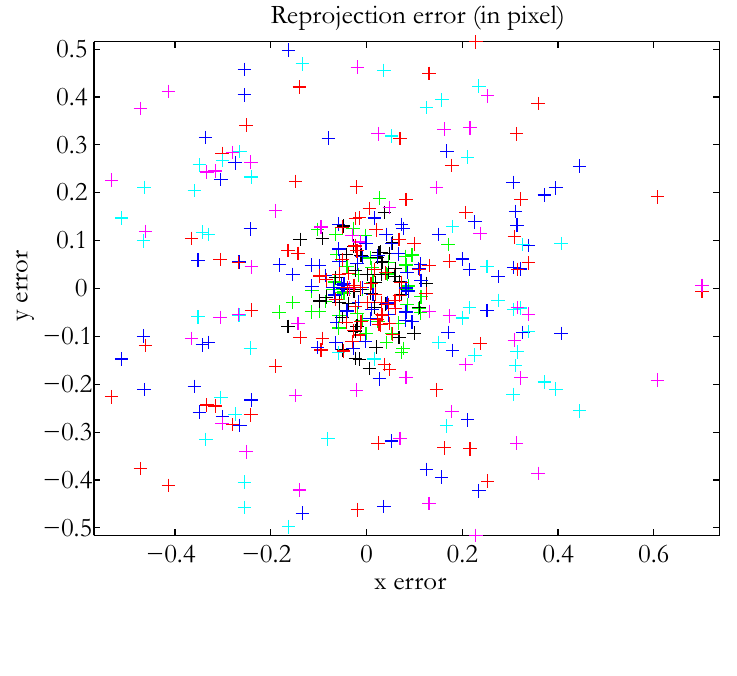
Figure 10. Reprojection error: Difference in pixel coordinates between the position of grid corners observed in the image and that predicted by the computed calibration parameters. Each color corresponds with the position of a checkerboard. In this figure, only six positions have been considered for the purpose of